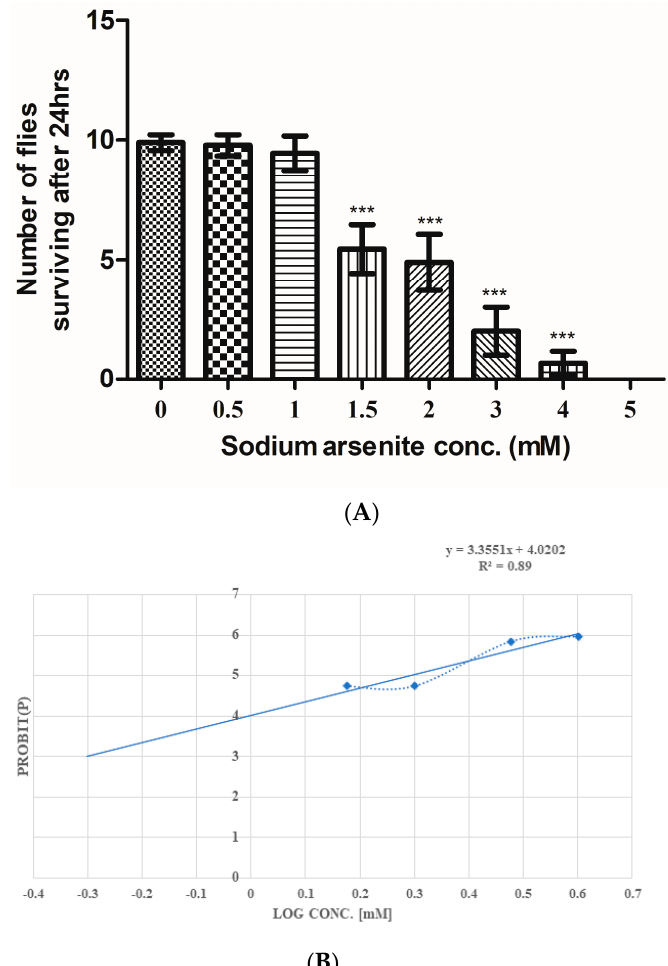
Figure 3. ( A ) The graph shows sodium arsenite (III) treated adult Drosophila melanogaster survivability within 24 h. Bars represent the means ± S.D. The significant mean difference ( p < 0.05) between treated and untreated flies was analyzed by a one-way analysis of variance (ANOVA) (*** p < 0.0001). ( B ) The lethal concentration of sodium arsenite for flies within 24 h using the probit linear regression statistic is shown. Slope intercepts at 4.02 on the y -axis, log concentration is 0.29 mM, and the linear equation is y = 3.35x + 4.02 with R squared value as 0.89. The LC50 obtained is 1.96 mM.